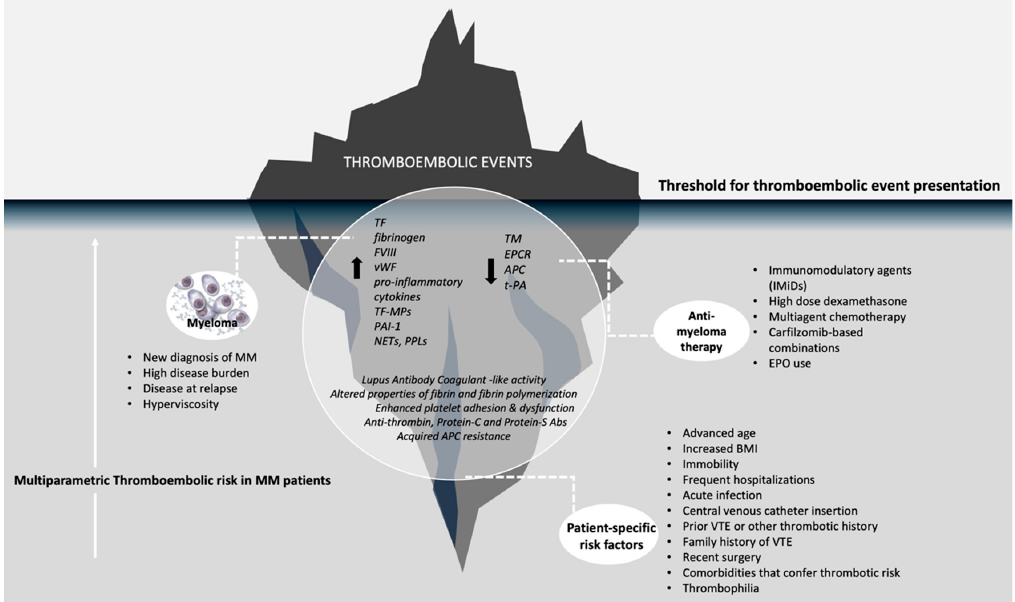
Figure 1. Risk factors for thrombosis in multiple myeloma. MM: multiple myeloma, TF: tissue factor, FVIII: factor VIII, vGF: von Willenbrand factor, TF-MPs: tissue factor-derived microparticles, PAI-1: plasminogen activator inhibitor, NETs: neutrophil extracellular traps, PPLs: procoagulant phospholipids, TM: thrombomodulin, EPCR: endothelial protein C receptor, APC: activated protein C, t-PA: tissue plasminogen activator, Abs: antibodies, EPO: recombinant erythropoein, BMI: body mass index, VTE: venous